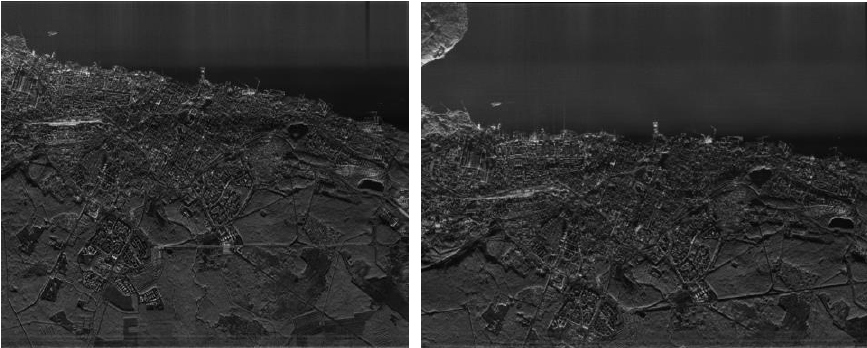
Fig. 9. Examples of radar images processed from focused radio holograms obtained from results of radar sounding at L- and X- band in 1 July, 2019, near Petrozavodsk from the board of flying laboratory IL-18D № 75713 with new on-board